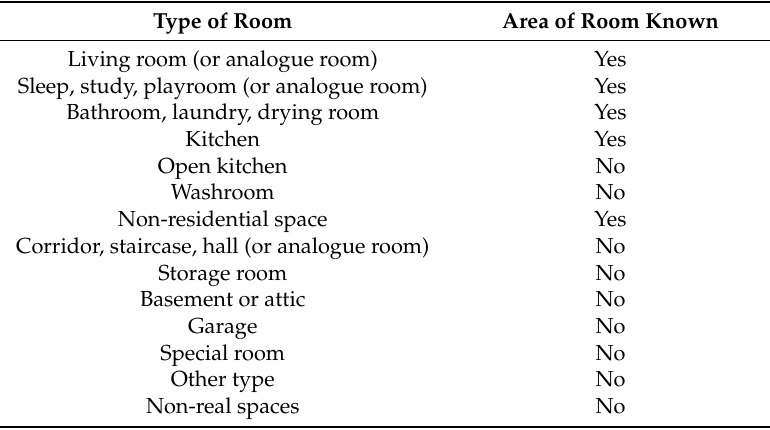
Table 2. Fixed categories of rooms in the Energy Performance Certificates